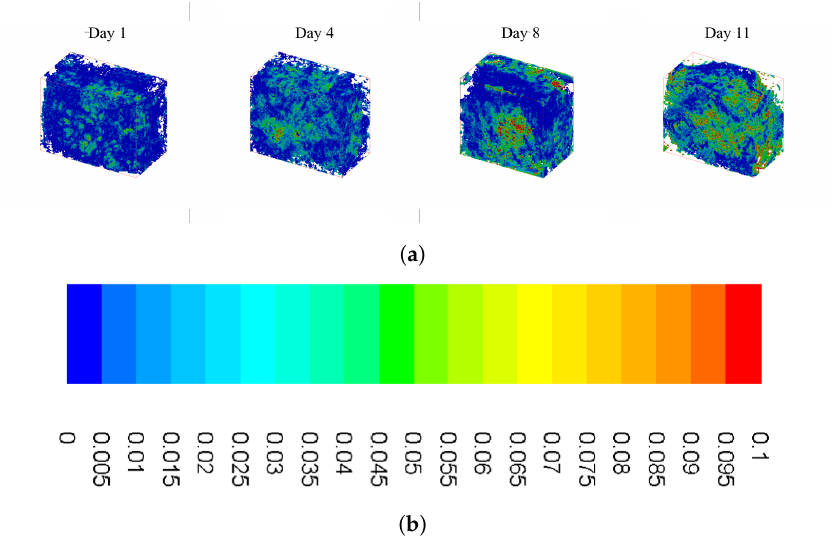
Figure 6. Summary of wall shear stress heat maps for constructs cultured under osteoconductive conditions. ( a ) Wall shear heat maps for Day 1 (far left) to Day 11 (far right) obtained using the custom lattice Boltzmann method code. ( b ) Scale bar: values given in g cm · s 2